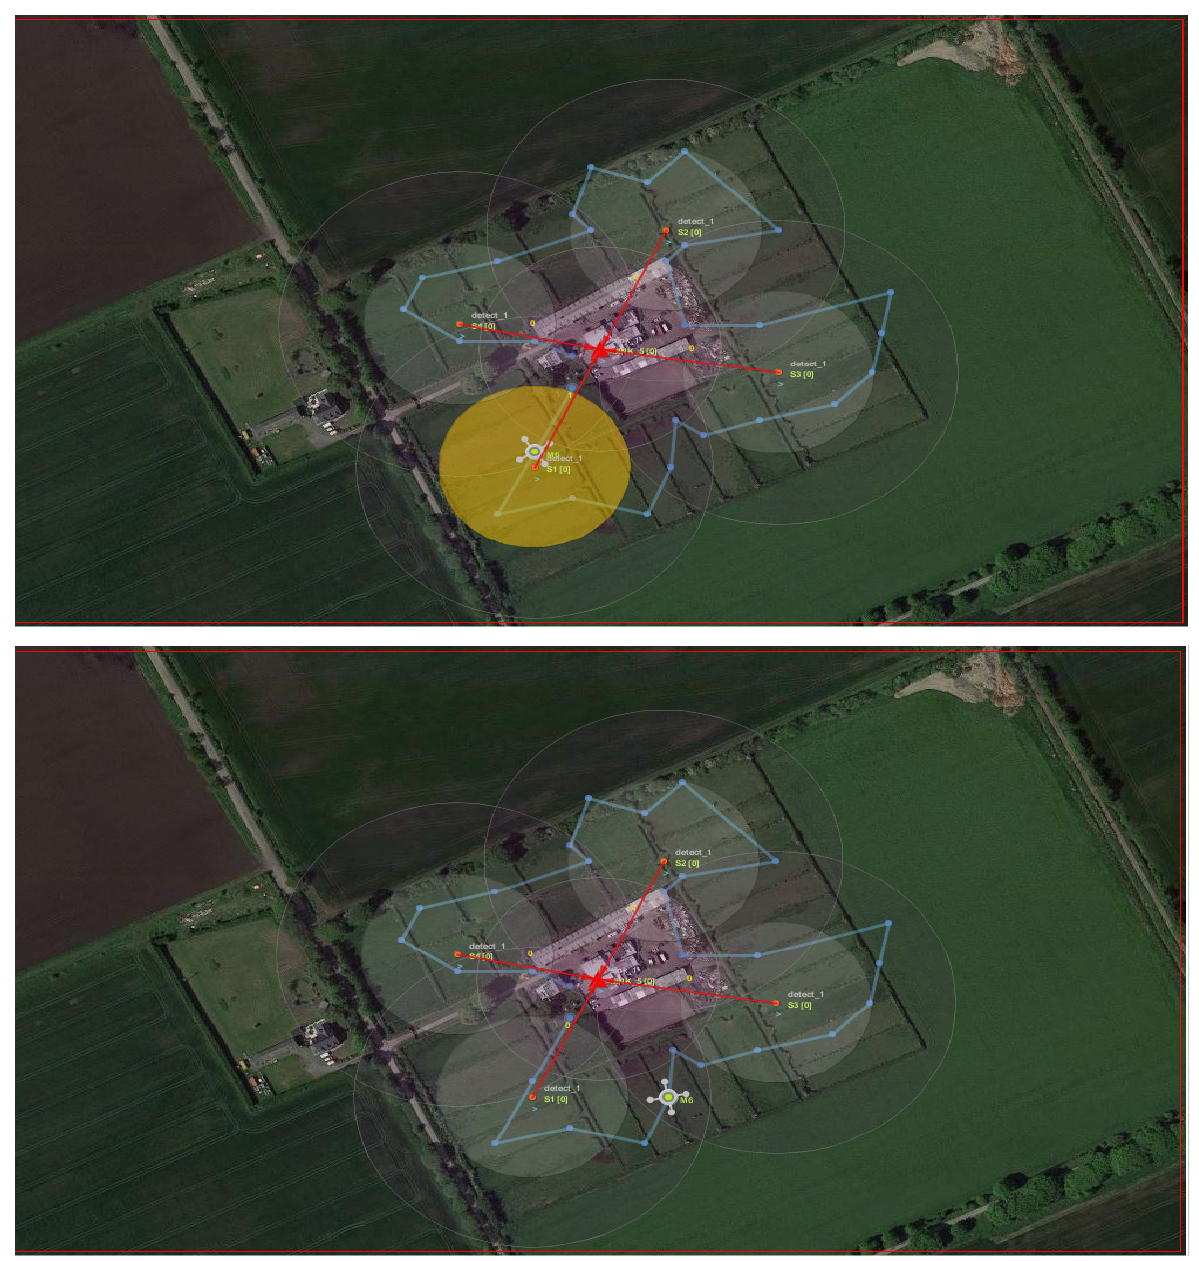
Figure 9. Drones and insects moving to different clusters in Field.